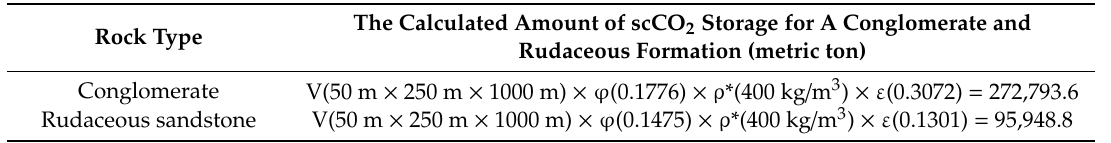
Table 3. The scCO 2 storage capacity of conglomerate and rudaceous formations at the Janggi Basin (unit—metric ton).